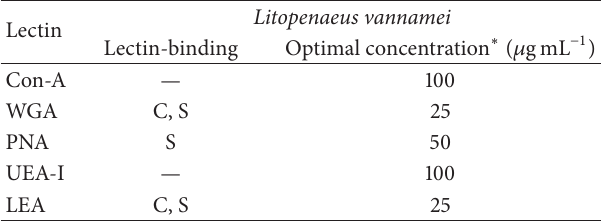
Table 2: Fluorescent